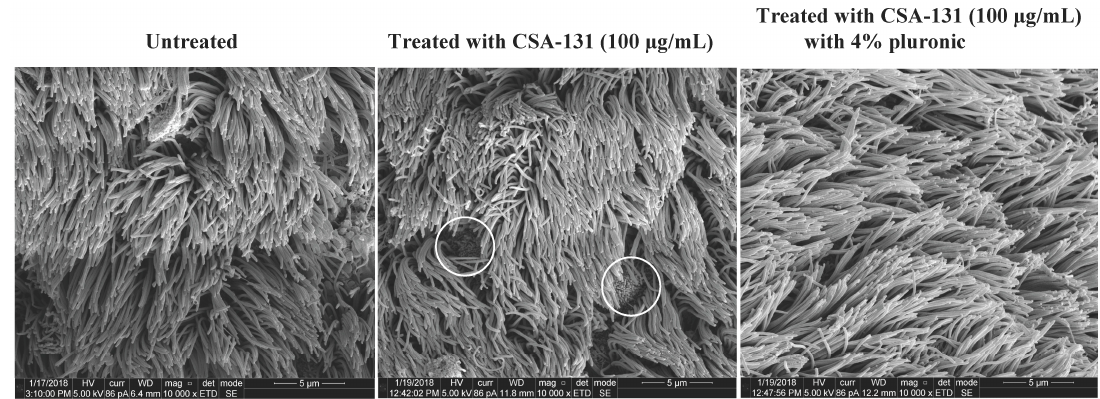
Figure 6. SEM images of cilia on porcine trachea explants untreated, treated with CSA-131 at 100 µg/mL, and treated with CSA-131 at 100 µg/mL with 4% pluronic. Exposed goblet cells are circled in the image of the sample treated with CSA-131 without pluronic.